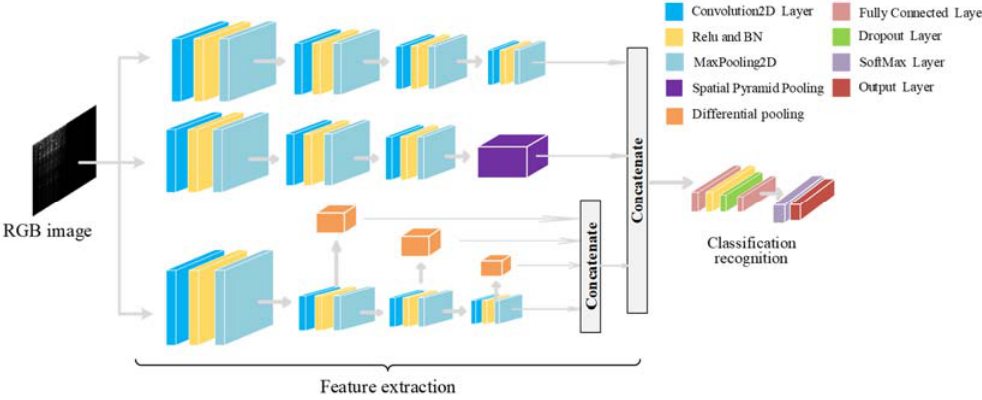
Figure 6. The structure of the optical fiber vibration signal recognition network.